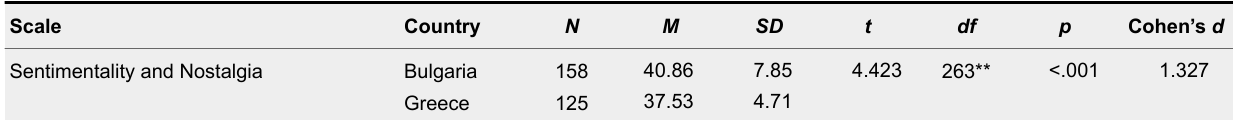
Differences in Sentimentality and Nostalgia Between the Elderly People in Bulgaria and Greece Scale Sentimentality and